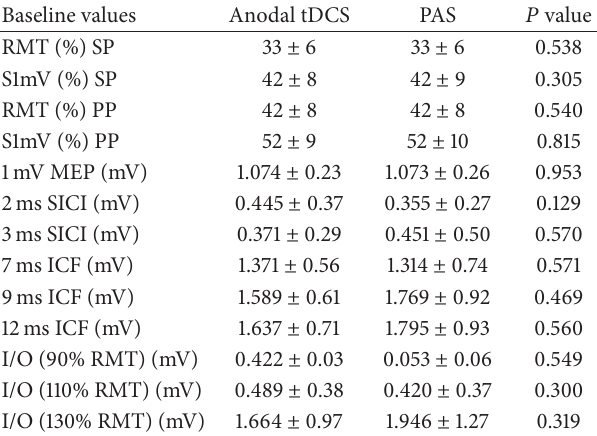
Table 2: Baseline comparisons of the dependent variables in both experimental setups. Data (untransformed) presented as mean ± standard deviation (SP: single-pulse measures; PP: paired-pulse